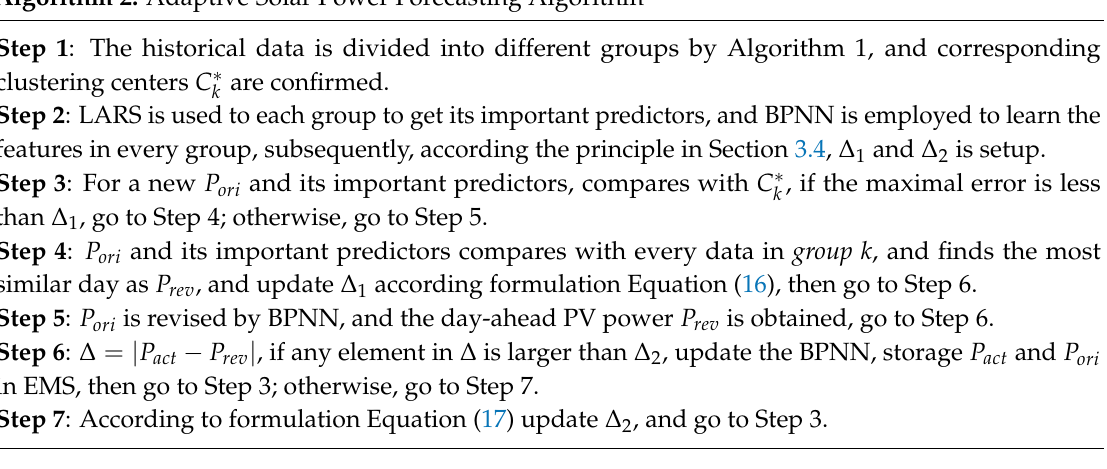
Algorithm 2: Adaptive Solar Power Forecasting